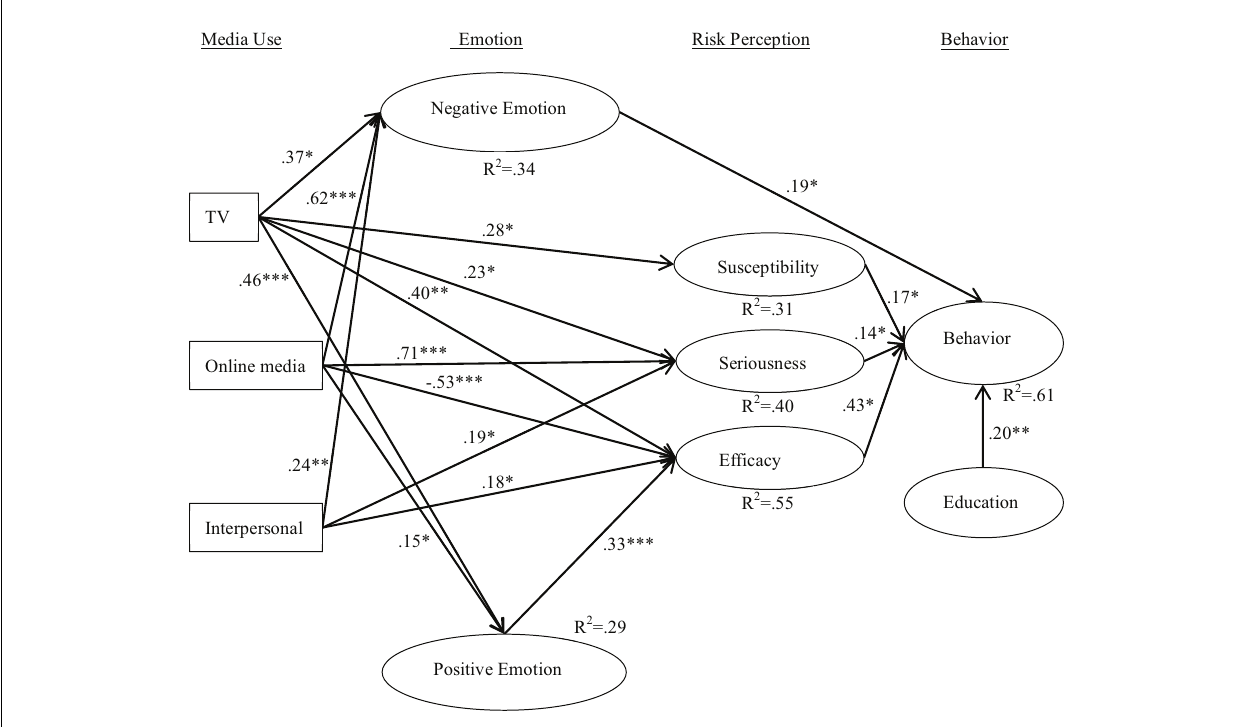
FIGURE 2 | Results of the structure model. N = 306, ∗ p < 0.05; ∗∗ p < 0.01; ∗∗∗ p <